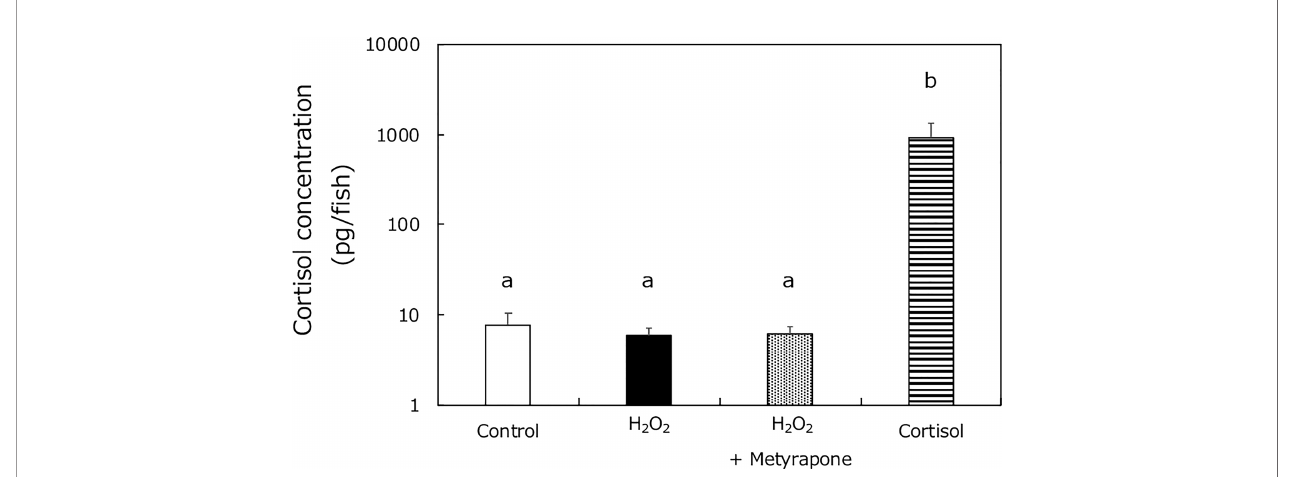
FIGURE 4 | Cortisol levels in medaka larvae at 5 dph. Control (white box), H 2 O 2 (black box), H 2 O 2 with metyrapone (dotted box), and cortisol treatment (stripe box) groups. Vertical bar: mean ± standard error of quadruplicate samples; a and b: signi fi cant difference (p <